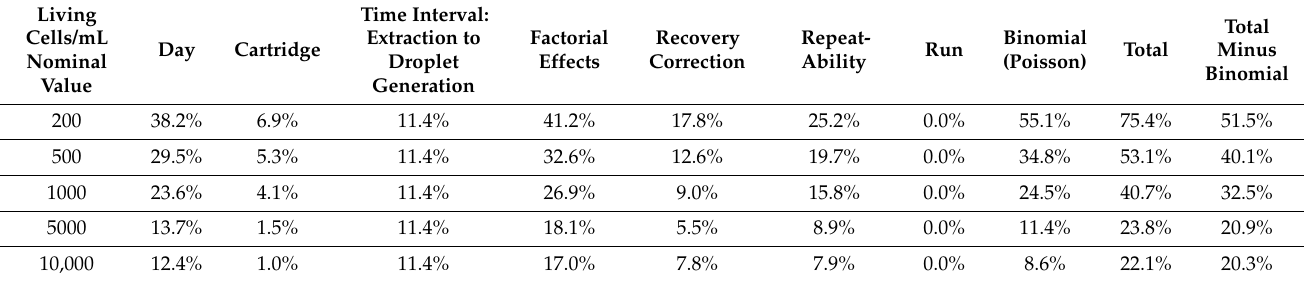
Table 10. Calculated RSD value for the technical uncertainty components—Supermix with dUTP.